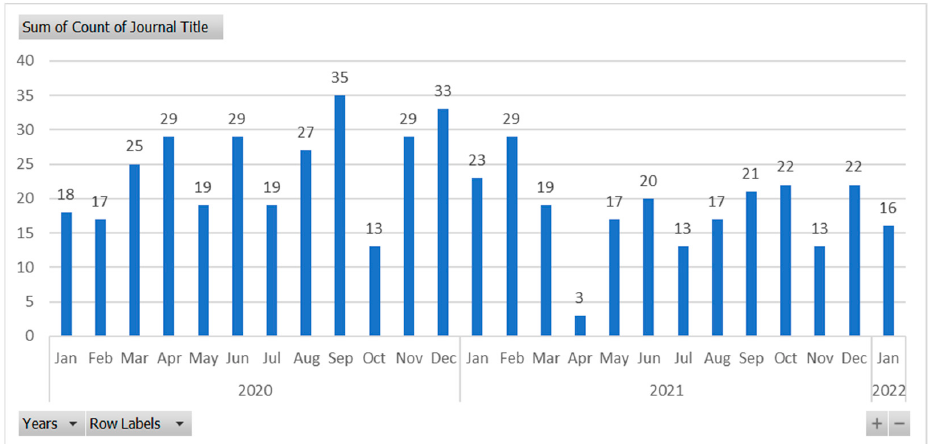
Figure 2. Monthly distribution of published papers as per the defined search strategy.